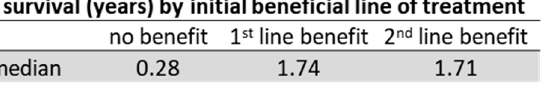
Figure 6. Patients maintained on a drug for at least three months in any line of therapy (within the first two lines) showed longer OS. Kaplan–Meier OS curves for all patients who received a minimum of two lines of targeted therapy stratified by timing of first clinical benefit (none, first-, or second-line). Subpanel: Statistical analysis showing no difference in the length of OS between first- and second-line therapies, but worse OS if patients could not be maintained on at least three months of drug treatment.